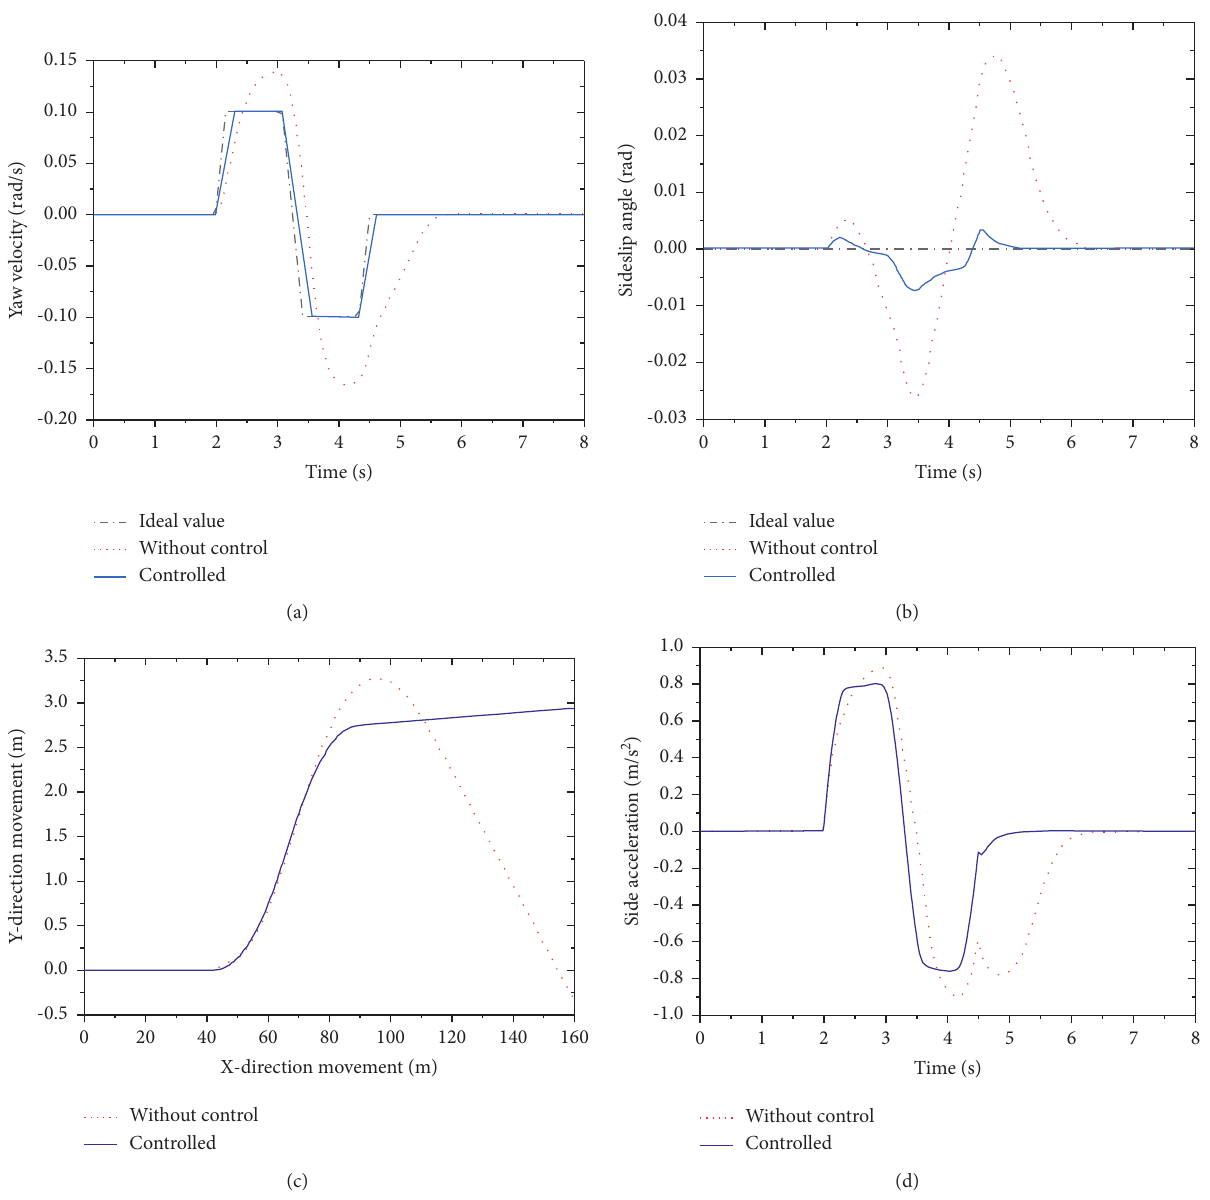
Figure 6: Simulation results of single lane change at an initial velocity of 30km/h (a) Change in yaw velocity (b) Change in sideslip angle (c) Vehicle trajectory (d) Change in lateral